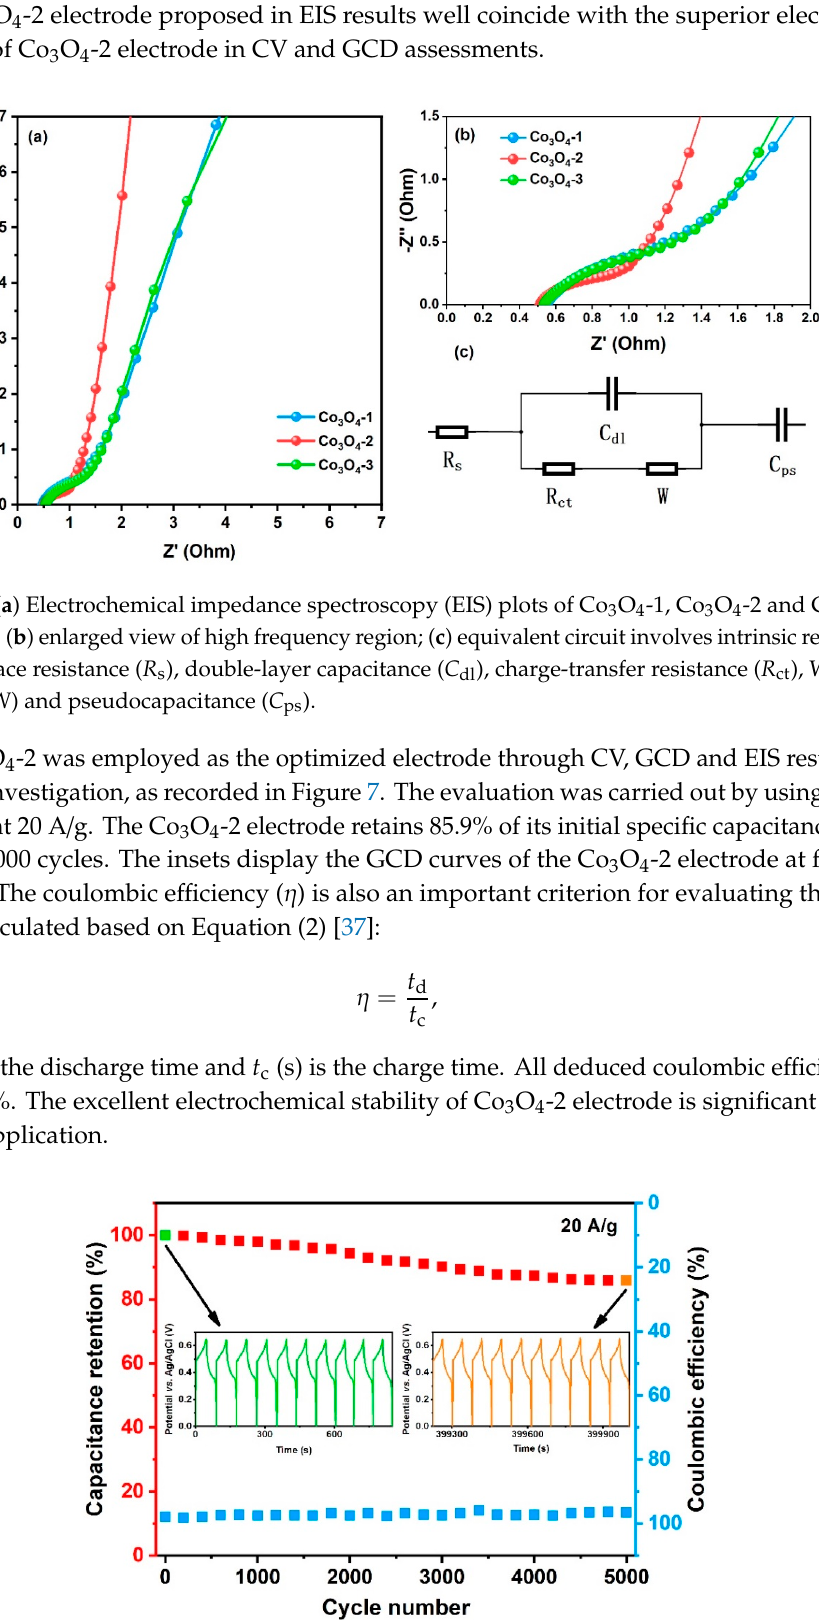
Figure 7. Cycling performance and coulombic efficiency of Co 3 O 4 -2 electrode. The insets are GCD curves at the first and last 10 cycles.